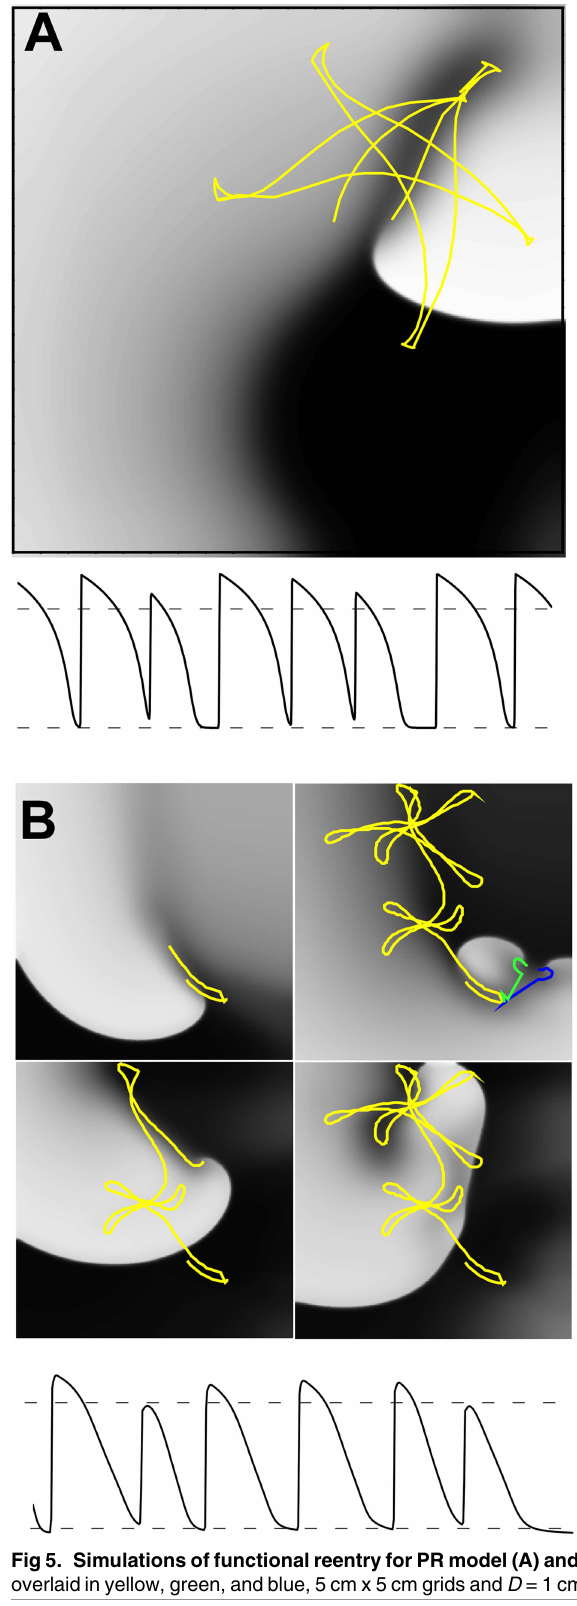
Fig 5. Simulations of functional reentry for PR model (A) and Mahajan model (B). Tip trajectories overlaidin yellow, green, and blue, 5 cm x 5 cm grids and D = 1 cm 2